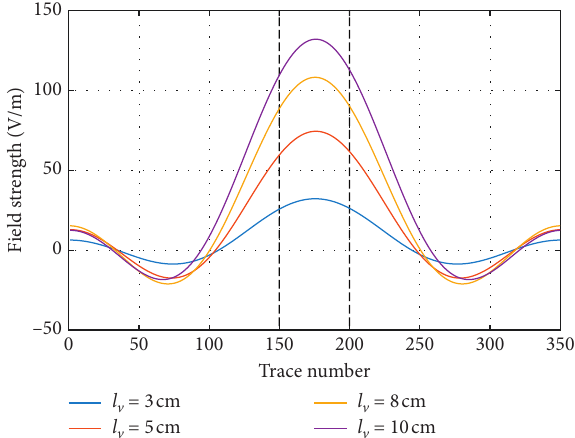
9: Threshold-based method to determine void